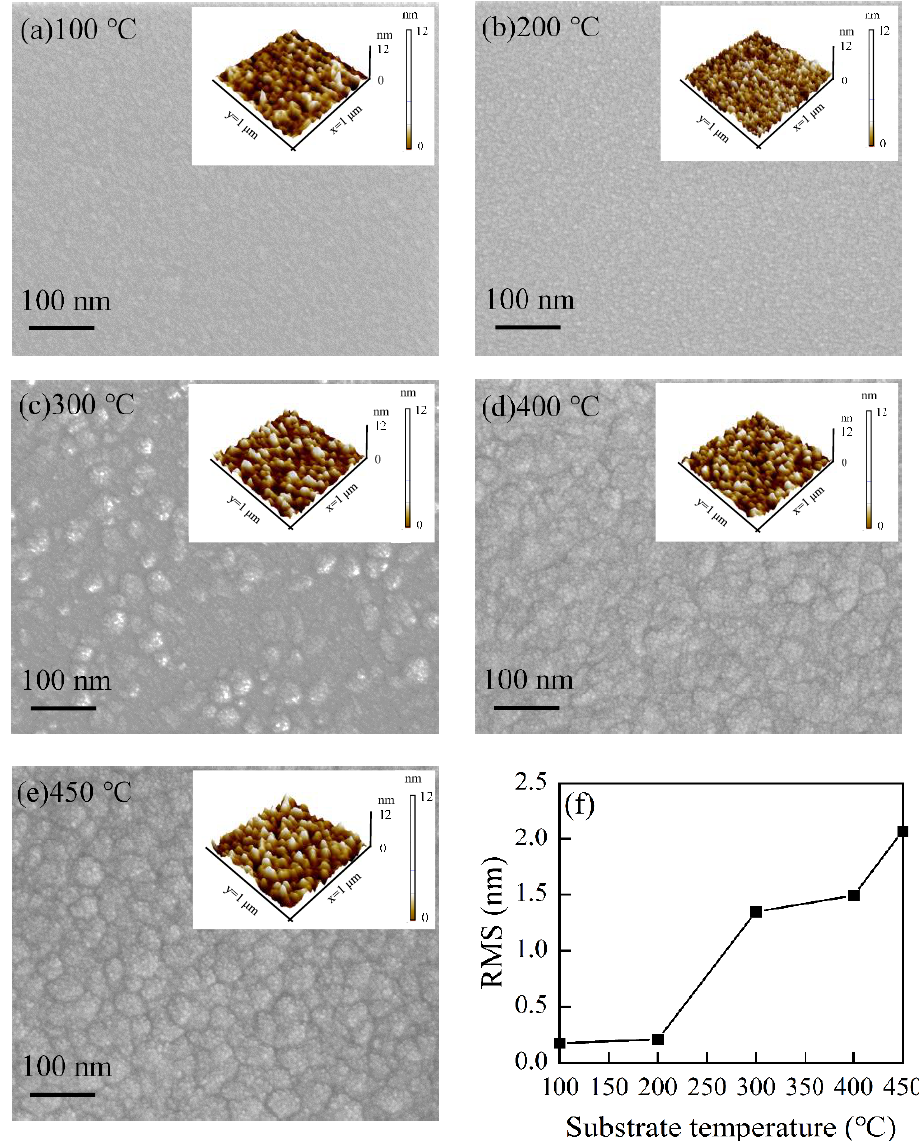
Figure 3. FESEM and AFM images of HfO 2 films with ( a ) 100 °C, ( b ) 200 °C, ( c ) 300 °C, ( d ) 400 °C and ( e ) 450 °C. ( f ) RMS roughness of HfO 2 by substrate temperatures.